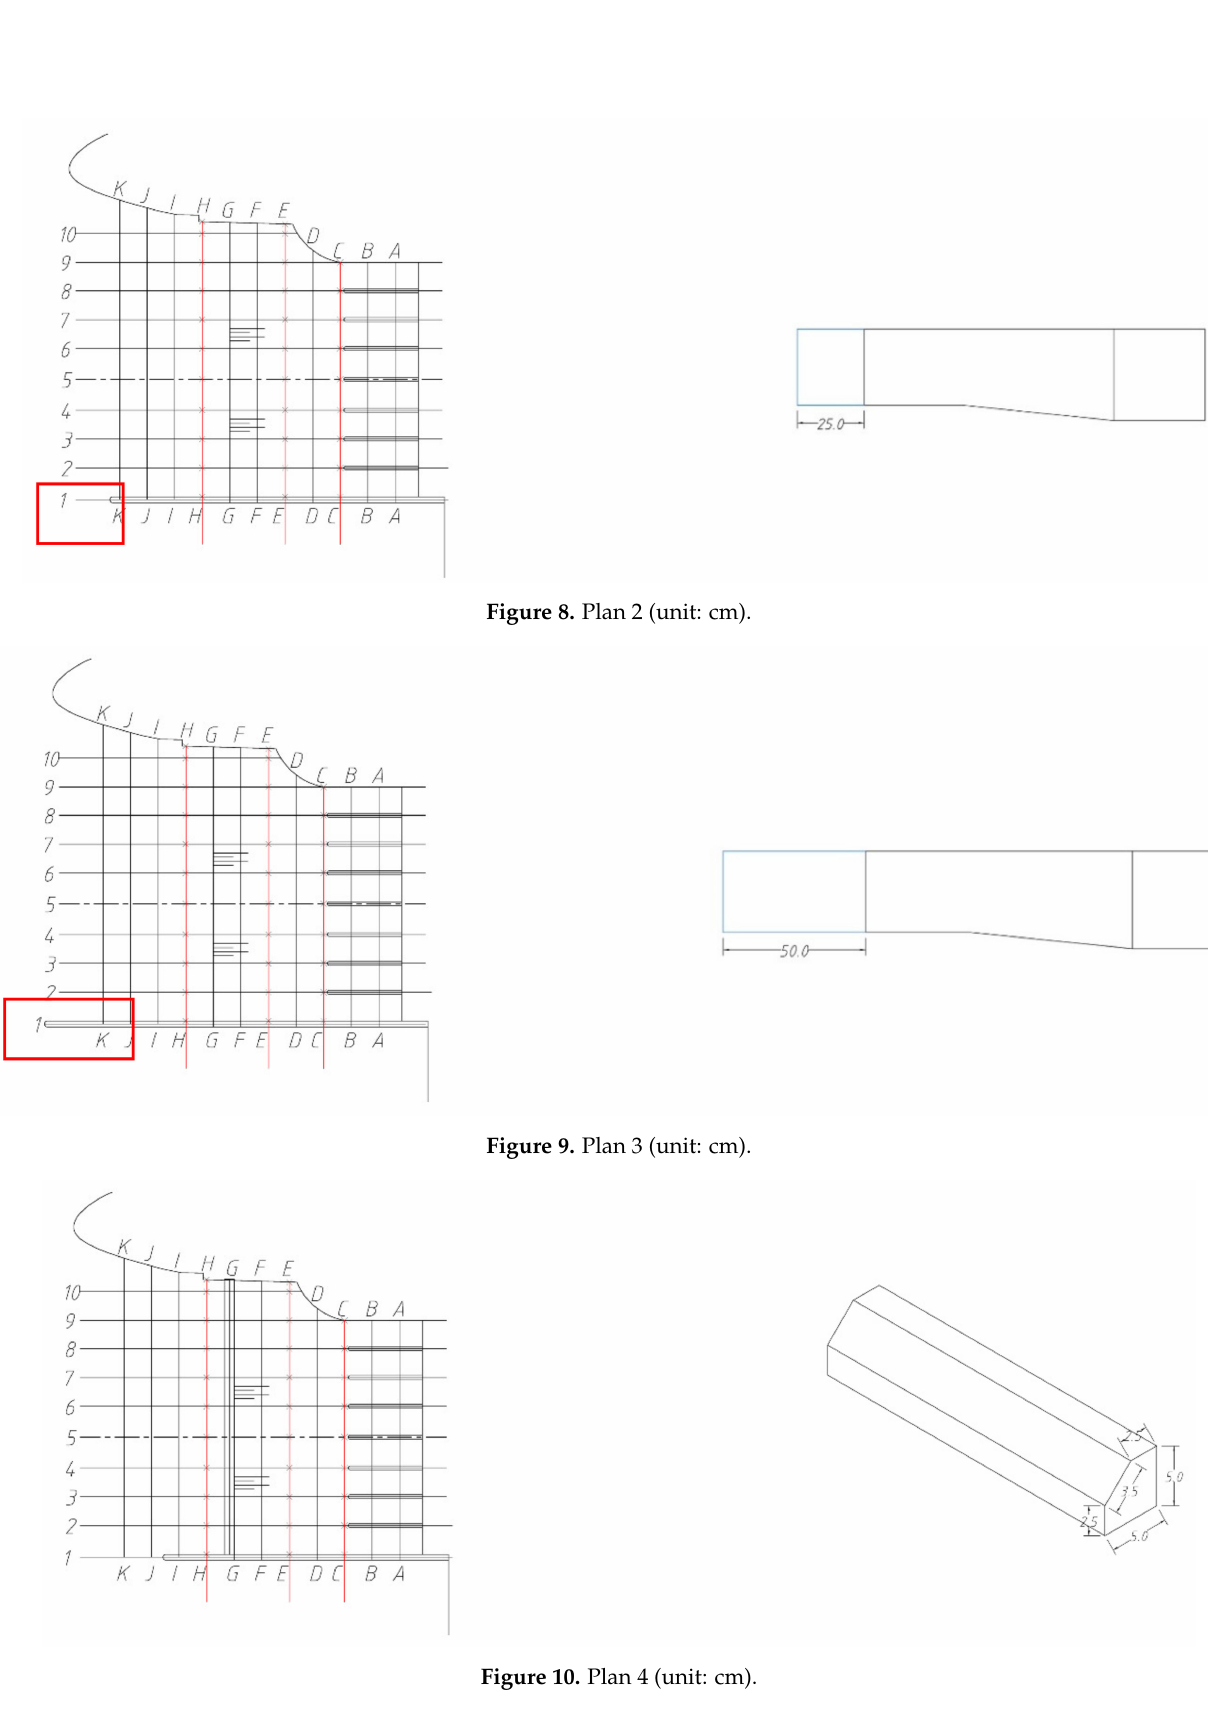
Figure 10. Plan 4 (unit: